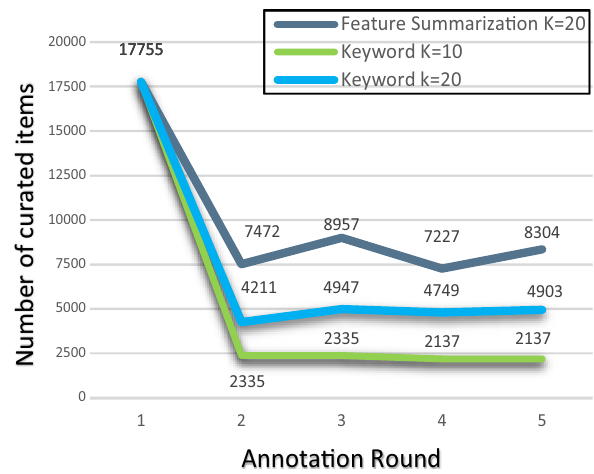
Fig. 6 Comparison between the number of items annotated using conceptual- and syntactic-level features (Budget Domain)